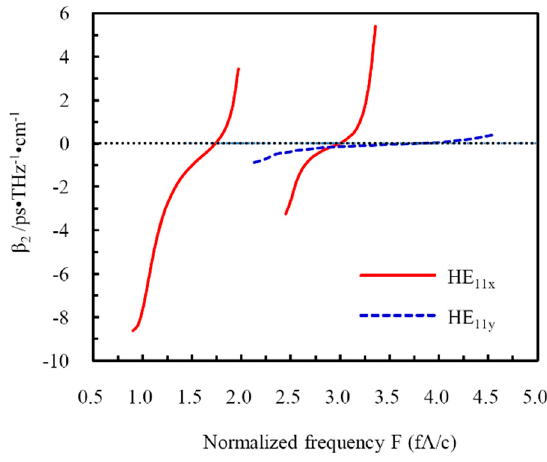
Figure 6. Dispersion parameter as a function of normalized frequency.